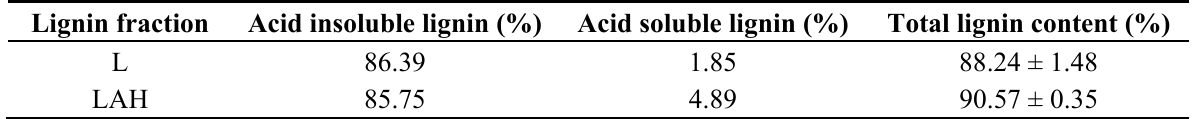
Table 1. Lignin content (acid insoluble and acid soluble) of the lignin fraction from the biorefinery before (L) and after (LAH) acid hydrolysis of hot-water